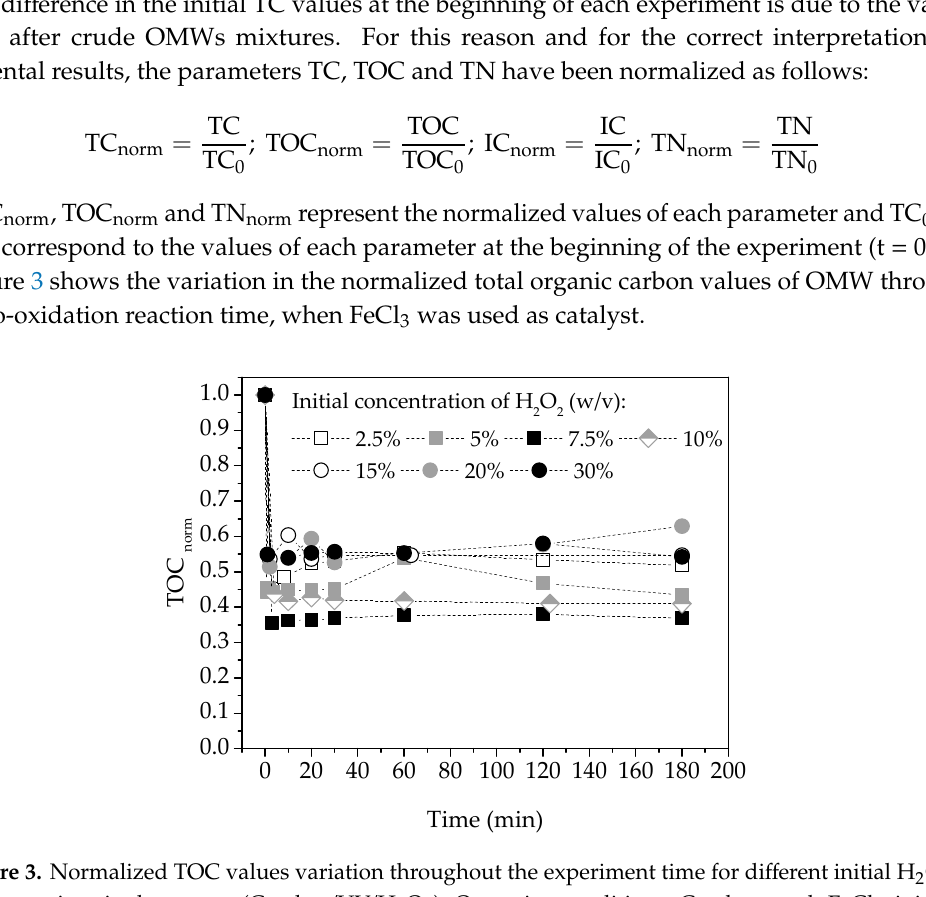
Figure 2. Variation of the TC content of OMW with respect to operating time for di ff erent concentrations of H 2 O 2 in the system (Catalyst / UV / H 2 O 2 ). Common operating conditions: pH = 3, T = 20 ◦ C, stirring speed = 150 rpm and the ratio [FeCl 3 ] / [H 2 O 2 ] = 0.03.